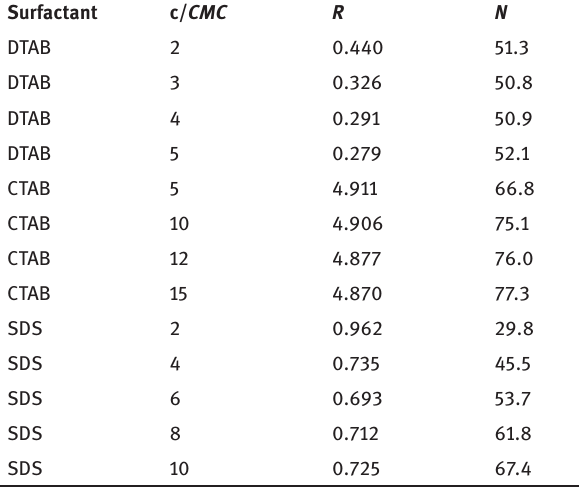
Figure 4: SDS concentration dependence of aggregation number N . The published aggregation number values taken from [26,33] are denoted by star symbols.